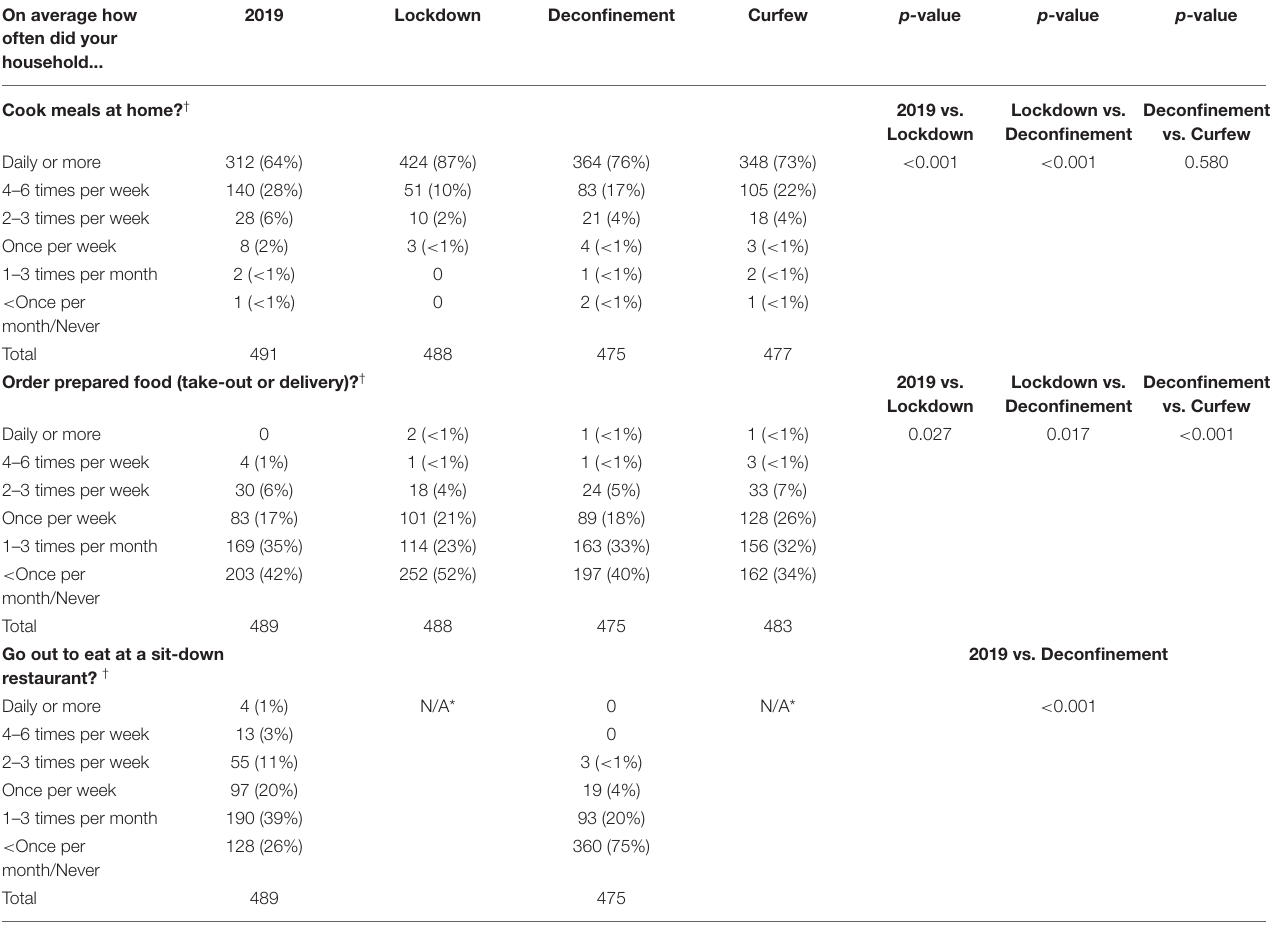
TABLE 3 | Changes in methods of meal preparation before and during COVID-19. On average how often did your